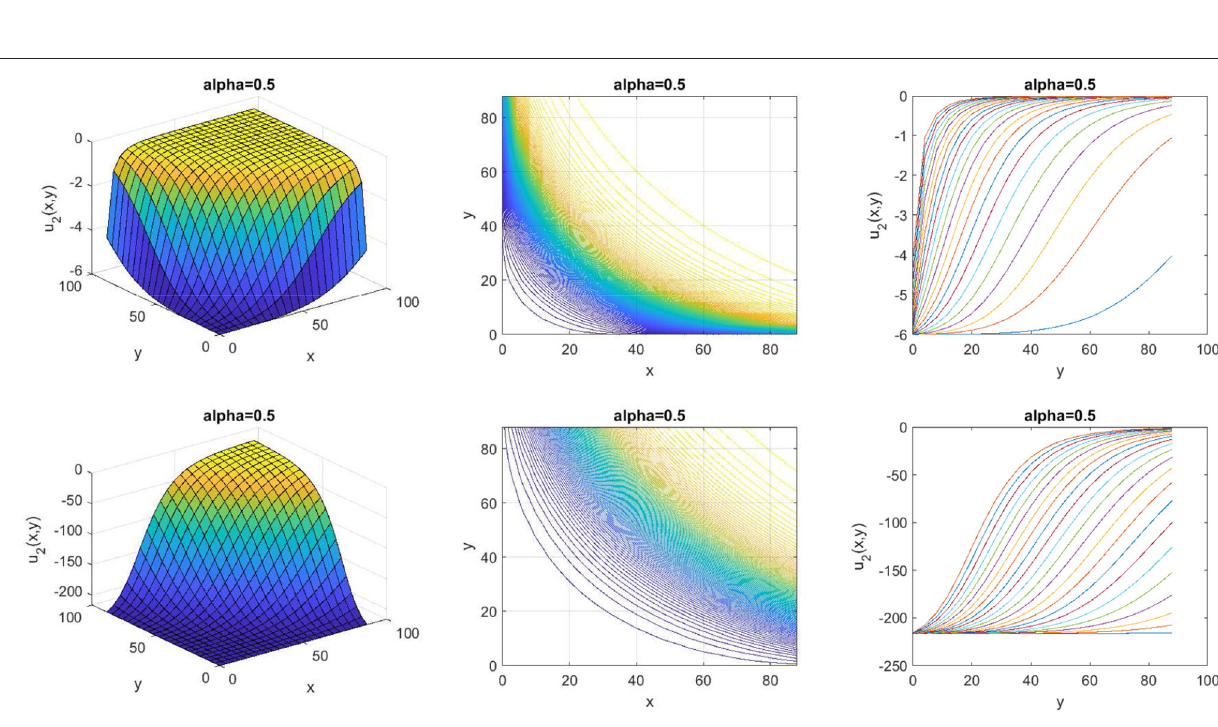
FIGURE 2 | Kink wave solution of Equation (26) in 3D, contour and 2D for Case